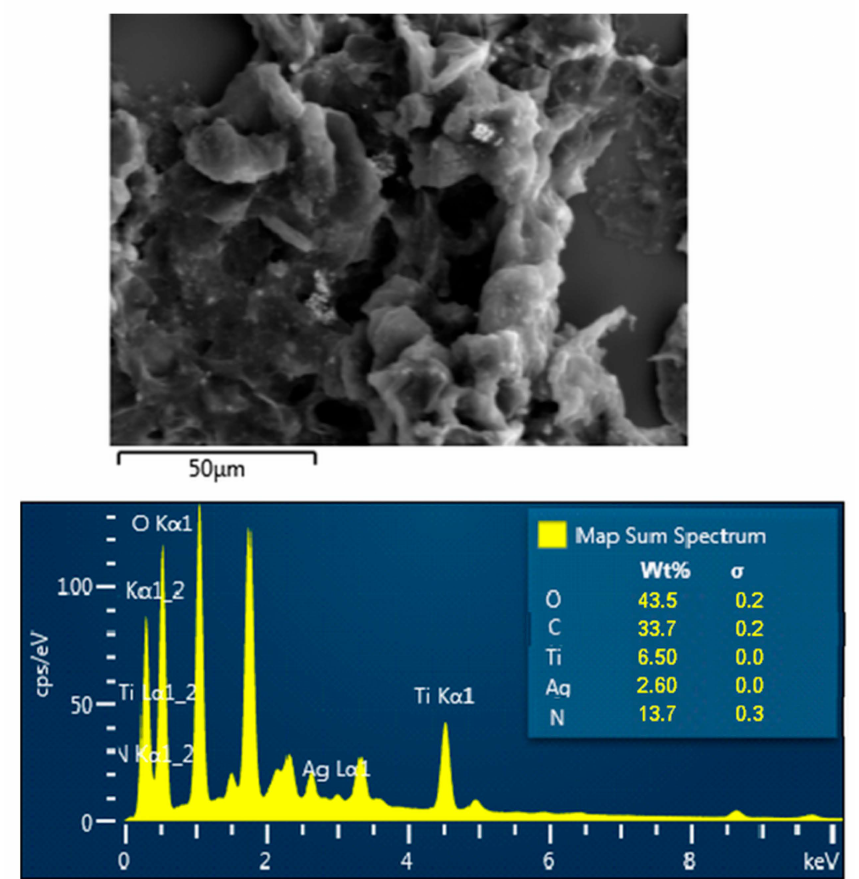
Figure 4. EDS elemental composition of the as-synthesized porous 3D black TiO 2 /Ag/N@rGO